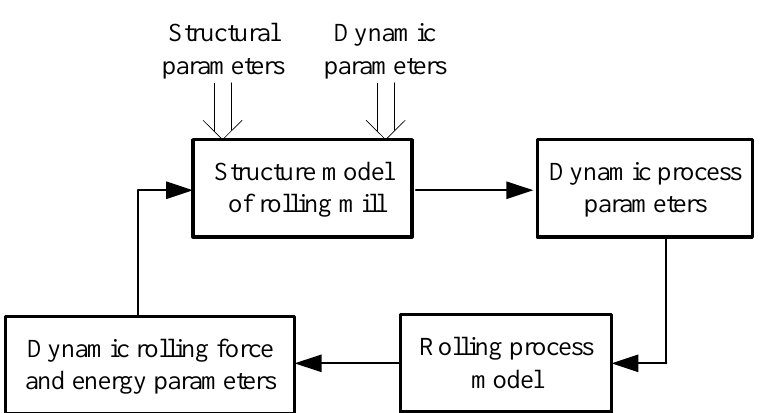
Figure 1. Coupling dynamics diagram of a rolling mill structure and rolling process.